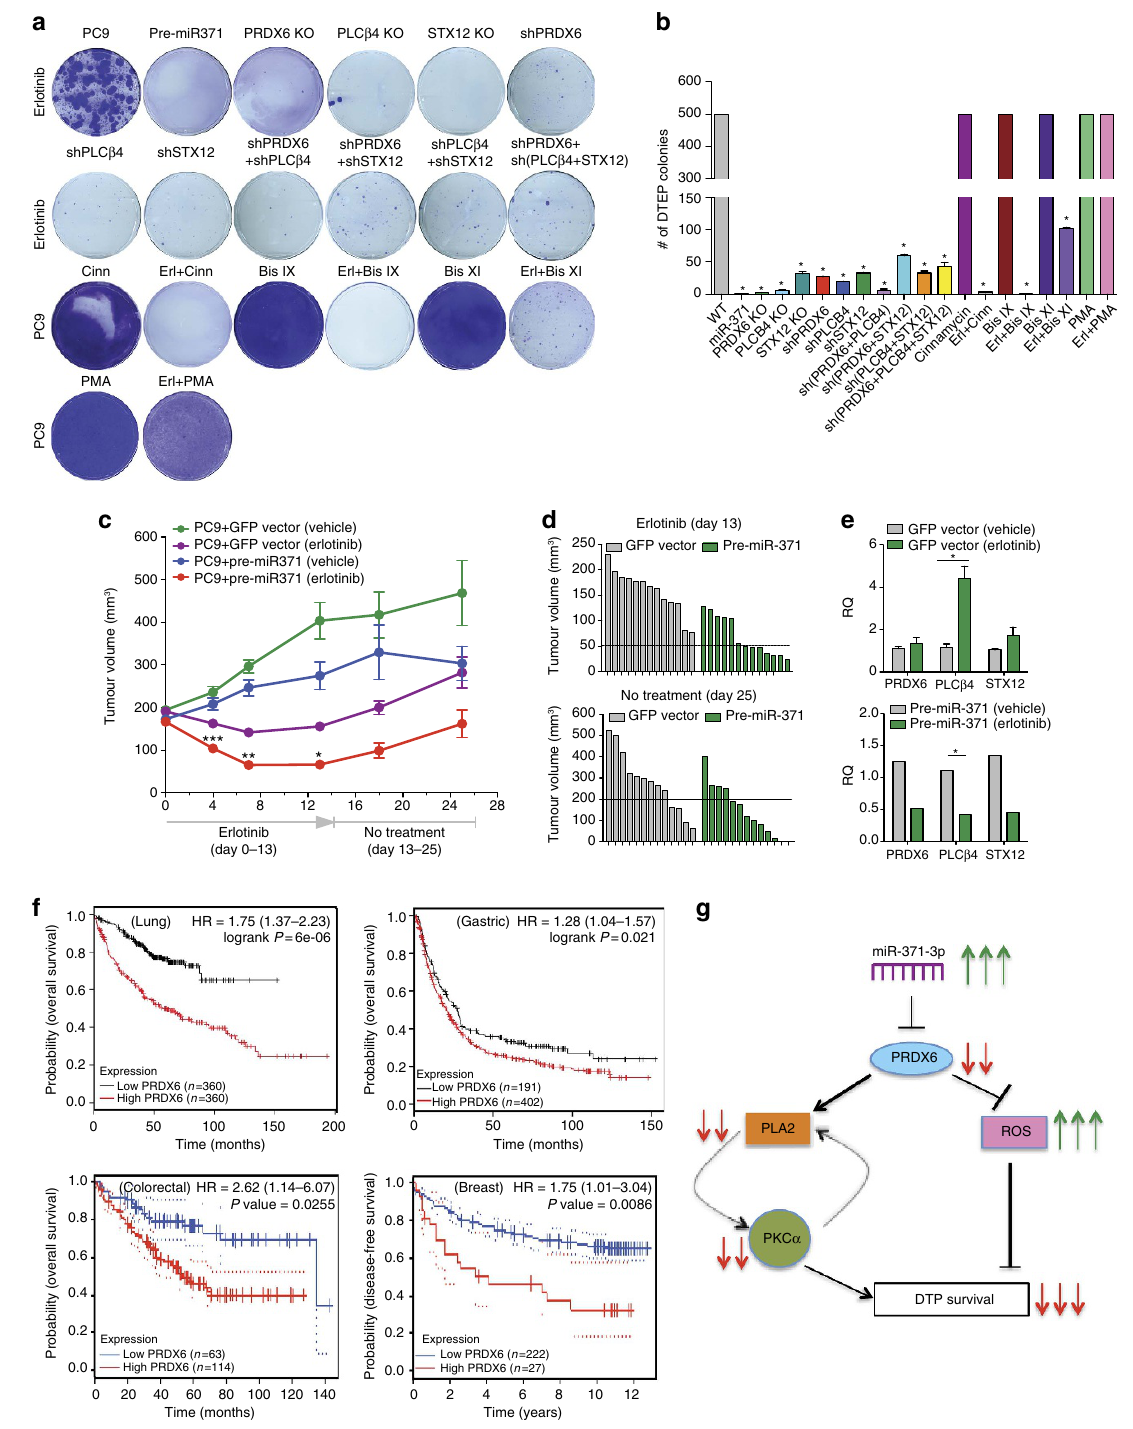
Figure 4 | PRDX6-mediated PLA2/PKC a activity is required for drug tolerance. ( a ) DTEP formation after erlotinib treatment is reduced in PC9 cells on pre-miR-371 overexpression, single, double or triple knockdowns of PRDX6 , PLC b 4 or STX12 , knockouts of PRDX6 , PLC b 4 or STX12 and treatment with PLA2/PKC a inhibitors or phorbol-12-myristate13-acetate (PMA; n ¼ 3). ( b ) DTEP colony counts obtained in a . Data are representative of at least two independent experiments. Data are represented as mean ± s.e.m. * ( P o 0.05, Student’s t -test) indicate significant differences from wild-type (WT) controls. ( c ) Xenograft studies with PC9 þ GFP and PC9 þ pre-miR-371 cell lines using erlotinib ( n ¼ 15). Data are represented as mean ± s.e.m. Interaction P values * P ¼ 0.0288, ** P ¼ 5.17e (cid:2) 05, *** P ¼ 0.00408. ( d ) Change in tumour volumes during drug treatment and after treatment cessation. ( e ) Quantitative PCR for expression of PRDX6 , PLC b 4 and STX12 mRNAs in xenograft tumours ( n ¼ 5). * P o 0.05, Student’s t -test. ( f ) Kaplan–Meier plots of overall survival of lung adenocarcinoma, colorectal cancer, gastric cancer and breast cancer patients; patient groups were separated based on PRDX6 mRNA expression. ( g ) Model depicting proposed mechanism for regulation of DTP survival via miR-371-3p and PRDX6